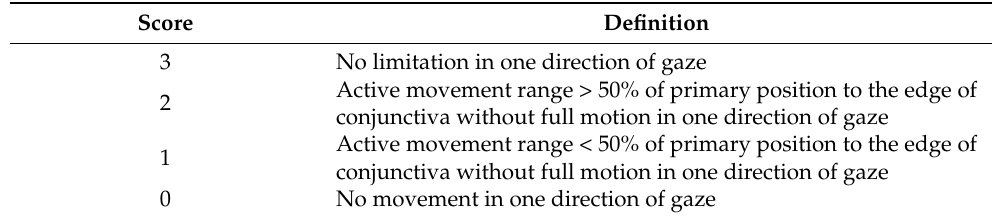
Table 1. The numeric scale for the measurement of EOM movement. Score Definition 3 No limitation in one direction of gaze Active movement range > 50% of primary position to the edge of 2 conjunctiva without full motion in one direction of gaze Active movement range < 50% of primary position to the edge of 1 conjunctiva without full motion in one direction of gaze 0 No movement in one direction of